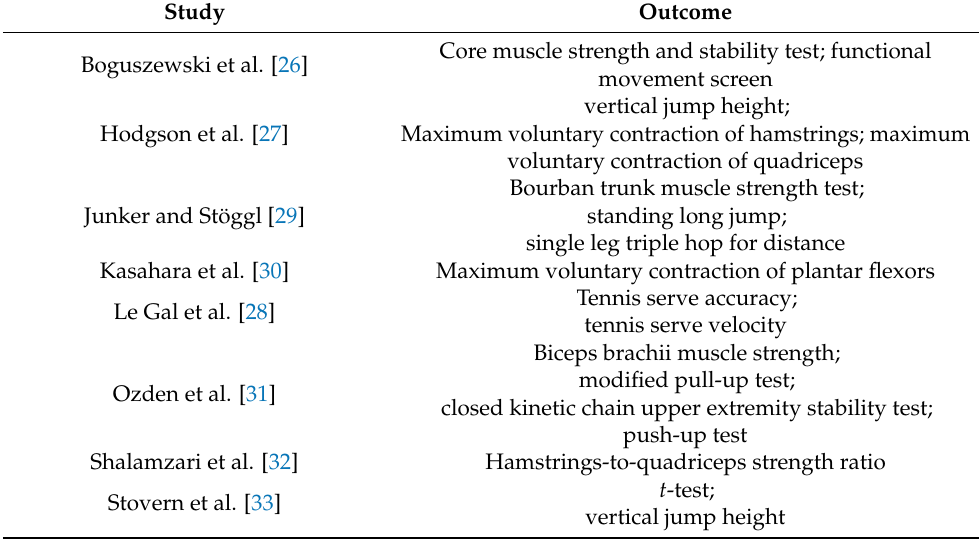
Table 2. Outcomes of the included studies (n = 8). IG = intervention group; CG = control group; nr = not reported; VAS = visual analogue scale; ROM = range of motion; bl = bilateral; RCT = randomized controlled trial; CT = controlled trial.